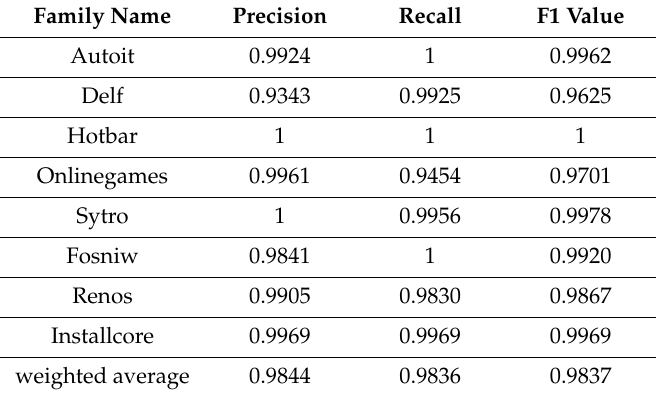
Table 5. The performance of the proposed model with 3-g.